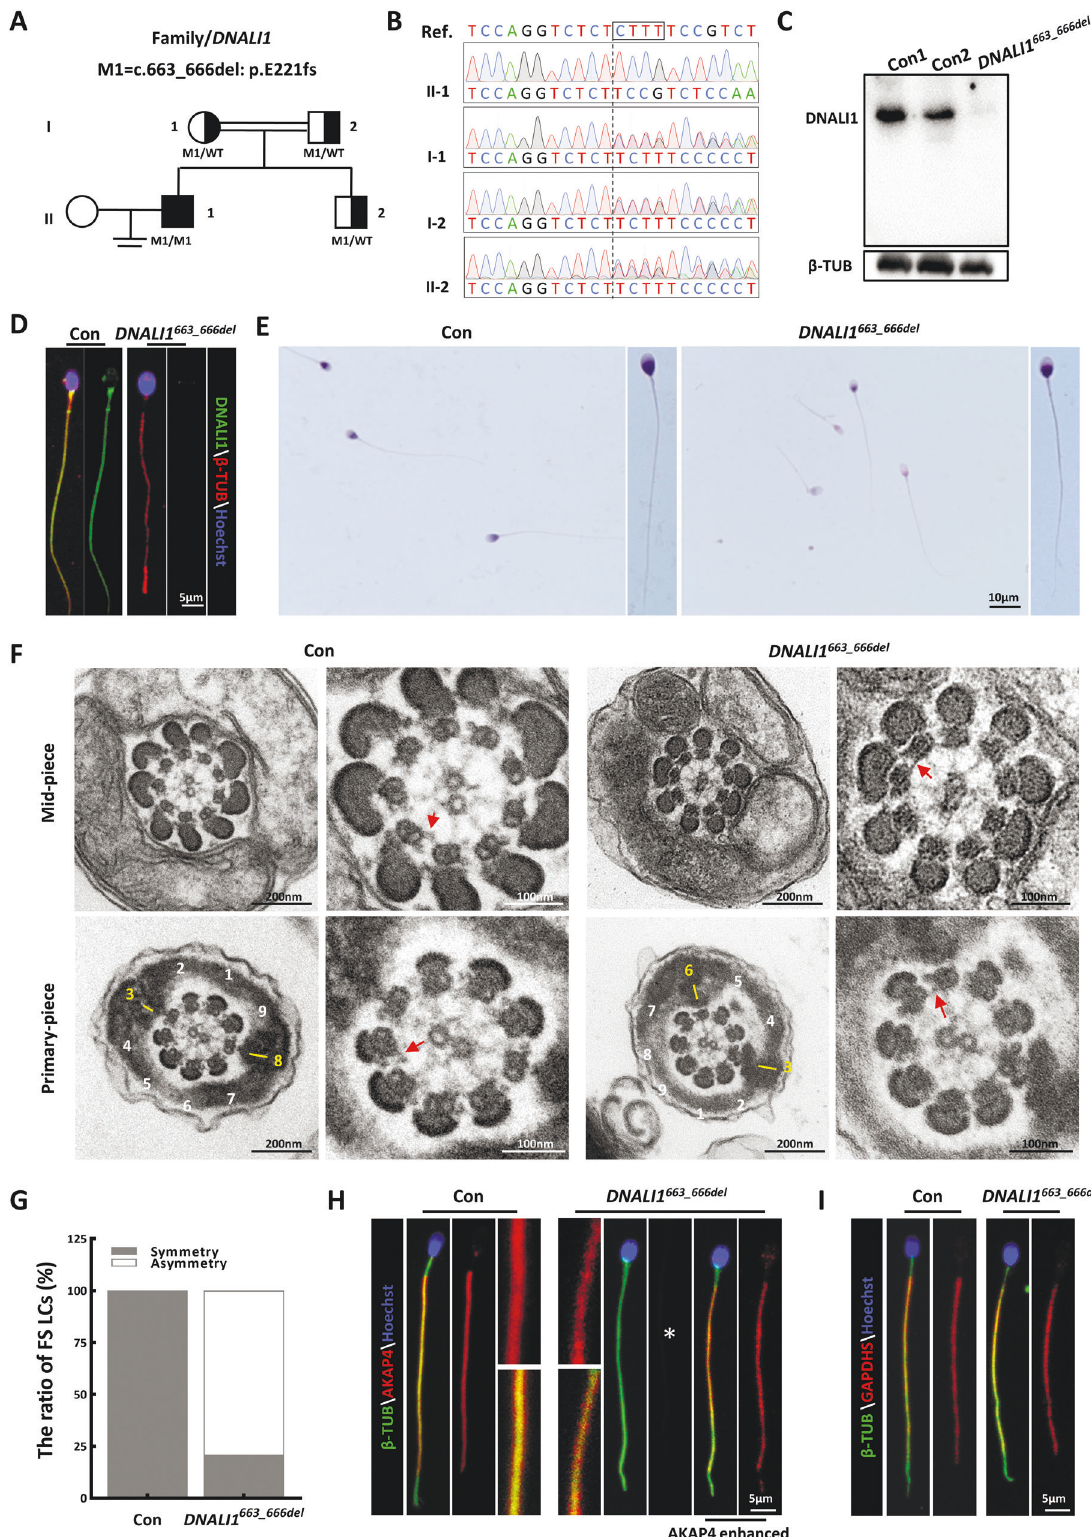
AKAP4-immunostained foci were relatively absent in the fl agella lacking DNALI1 (Fig. 1H). In contrast, the unaltered signal of GAPDHS, a spermatogenic glycolytic enzyme located within FS, was evident in the mutant samples (Fig. 1I). Cell Death and Disease (2023)